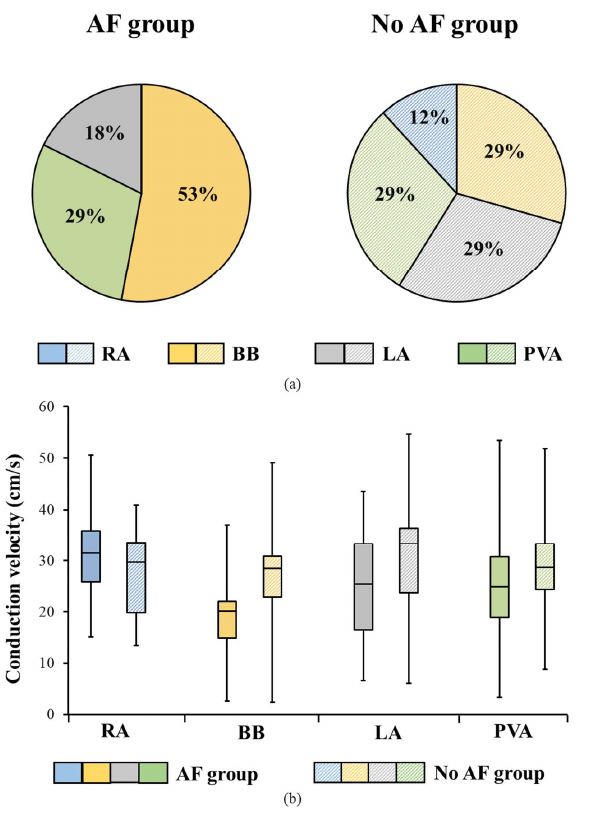
Figure 5. Predilection site for the lowest CV ( a ) Location of the lowest CV (defined as the 5th percentile of the relative frequency distribution of CV), within each AF patient (left) and no AF patient (right); ( b ) Distribution of the lowest CVs shown for each location separately. cm/s = centimeter/second; AF = atrial fibrillation; BB = Bachmann’s Bundle; LA = left atrium; PVA = pulmonary vein area; RA = right atrium.